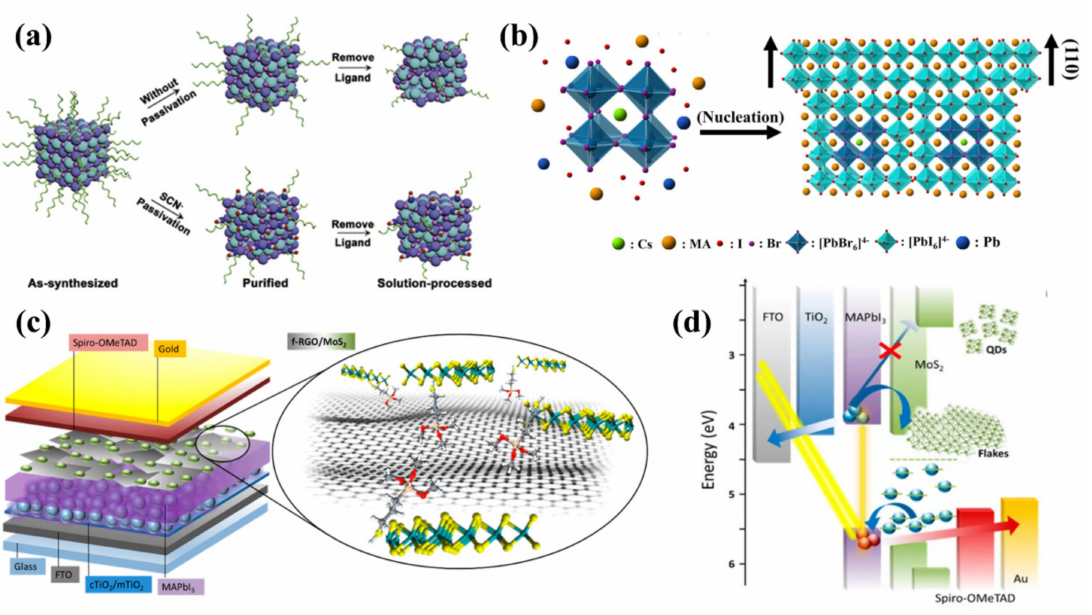
Figure 6. ( a ) Schematic comparing the CsPbI 3 QDs with and without short-chain thiocyanate anion (SCN − ) capping after removing the ligand chain on the QD surface using saturated Pb(OAc) 2 ethyl acetate (EA) solution. Reproduced from [104], with permission from Elsevier, 2018. ( b ) Schematic diagram of the nucleation mechanism of MAPbI 3 induced with CsPbBr 3 QDs. Reproduced from [111], with permission from IOP Science, 2020. ( c ) Schematic of the structure of a mesoporous PSC based on MoS 2 QDs. Reproduced from [115], with permission from American Chemical Society, 2018. ( d ) Schematic diagram of the energy band structure of a PSC with MoS 2 QDs as an interfacial layer. Reproduced from [115], with permission from American Chemical Society,